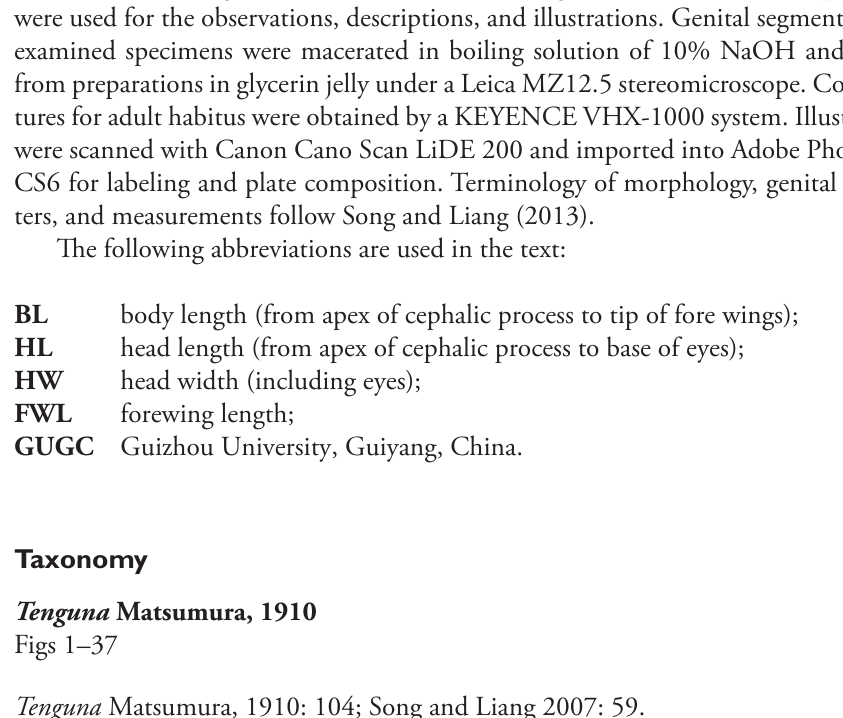
Diagnosis. Genus diagnostic characters: general color green or yellowish green (in death); vertex with median carina distinct and complete, lateral margins sub-parallel at base, slightly sinuate in front of eyes, then gradually narrowing to arrowhead at apex; pronotum with distinct median carina and two obscure lateral discal carinae, elevated only anteriorly; fore femur with one minute, short and blunt spine near apex; aedeagus with a pair of processes apically and phallobase with pairs of membranous lobes